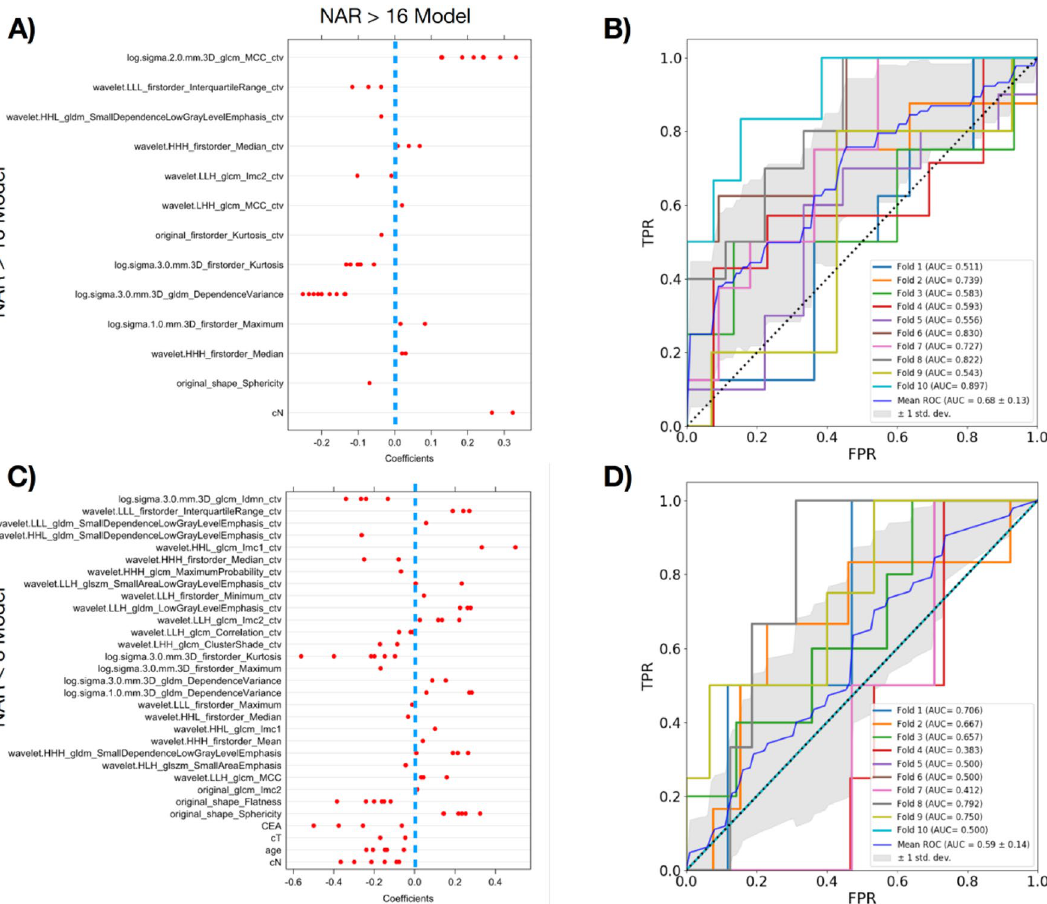
Figure 3. ( A , C ) The LASSO coefficients of the radiomics and clinical features in the NAR model for each of the fold in cross validation. Each red dot represents the coefficient of the feature in the model for a particular fold. The blue dotted line corresponds to coefficient 0. ( B , D ) This figure shows the 10 ROC curves for each of the 10 folds and final average ROC curve and the associated 95% confidence interval band in